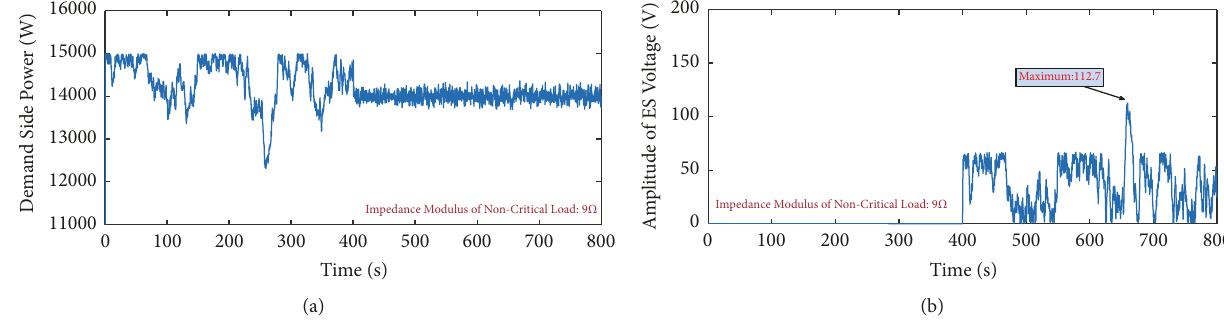
Figure 19: ES in series with a 9 Ω noncritical load. (a) Demand side power. (b) The amplitude of ES voltage.